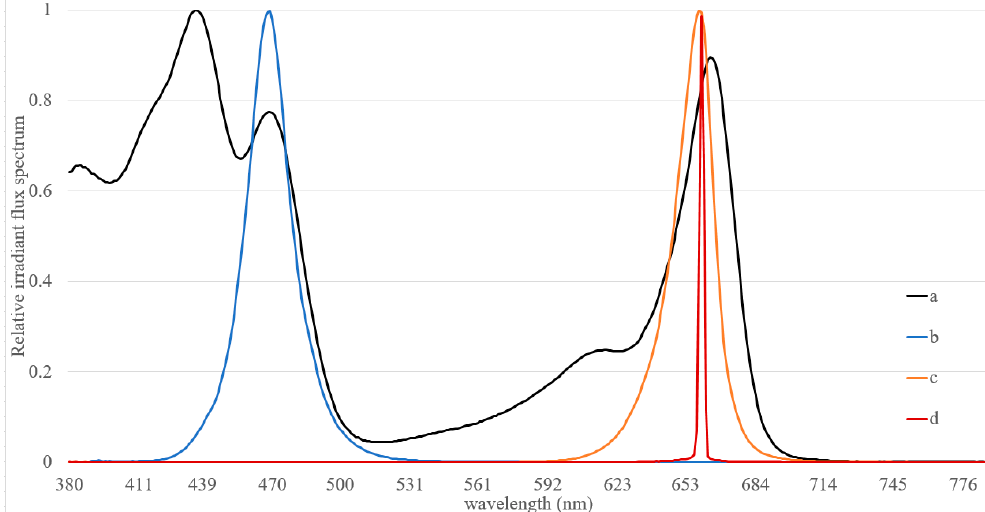
Figure 2. Relative irradiant flux spectrum. ( a ) is relative irradiant flux absorption spectrum of lettuce; ( b – d ) are emission spectra of blue light-emitting diode (LED), red LED, and red laser.